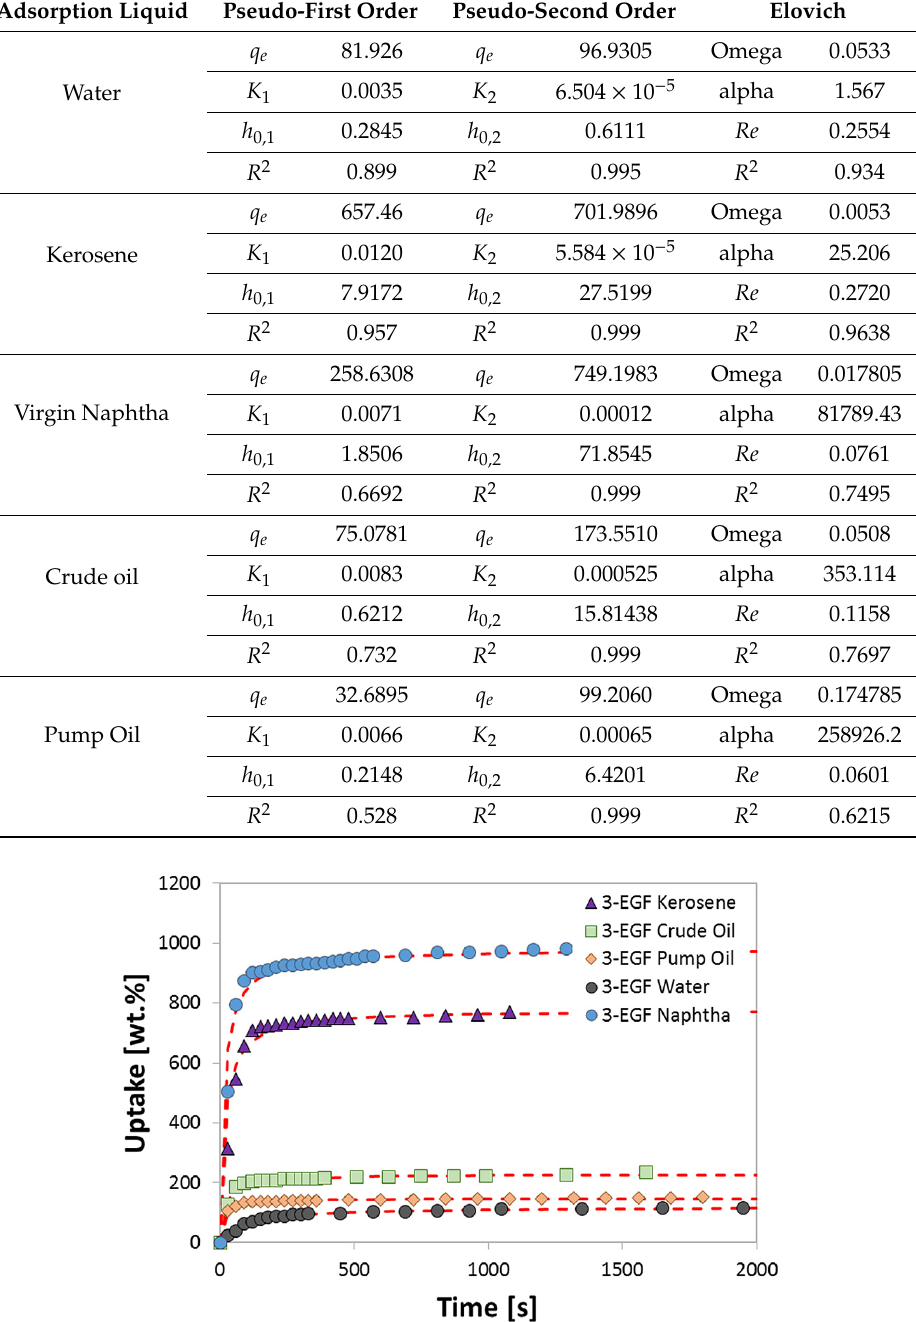
Figure 4. Pseudo-second order kinetics (dotted lines) of oil sorption into 3-EGF foam.